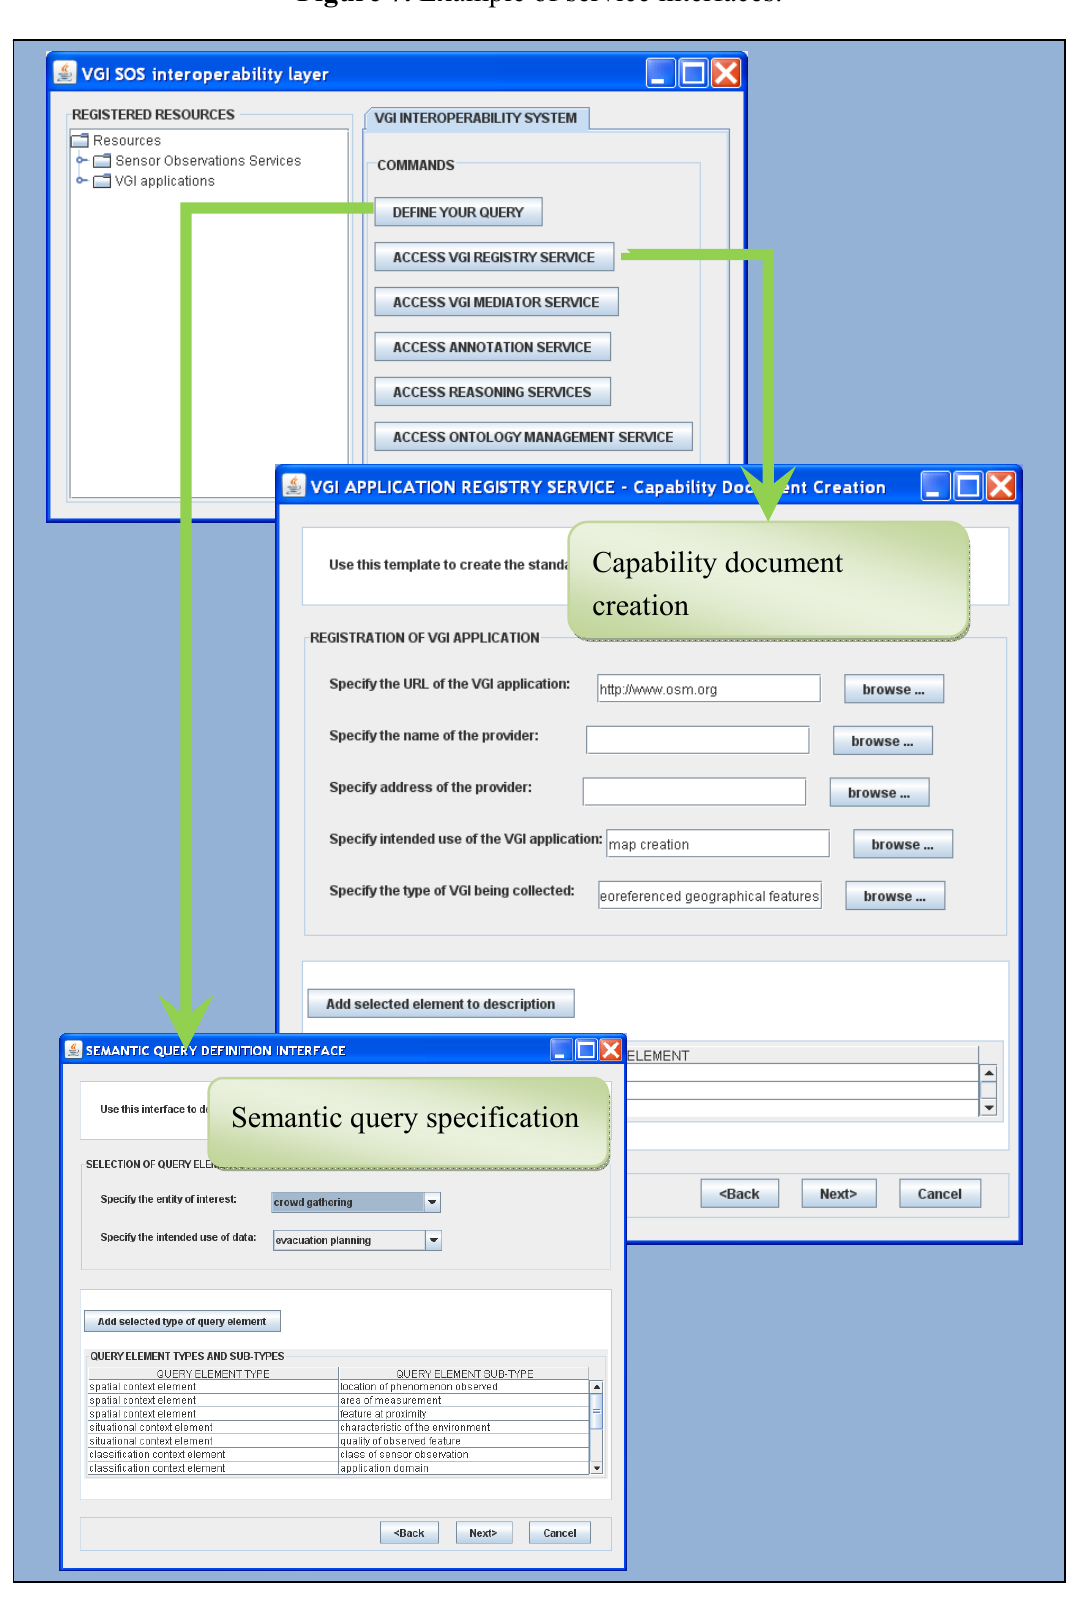
Figure 7. Example of service